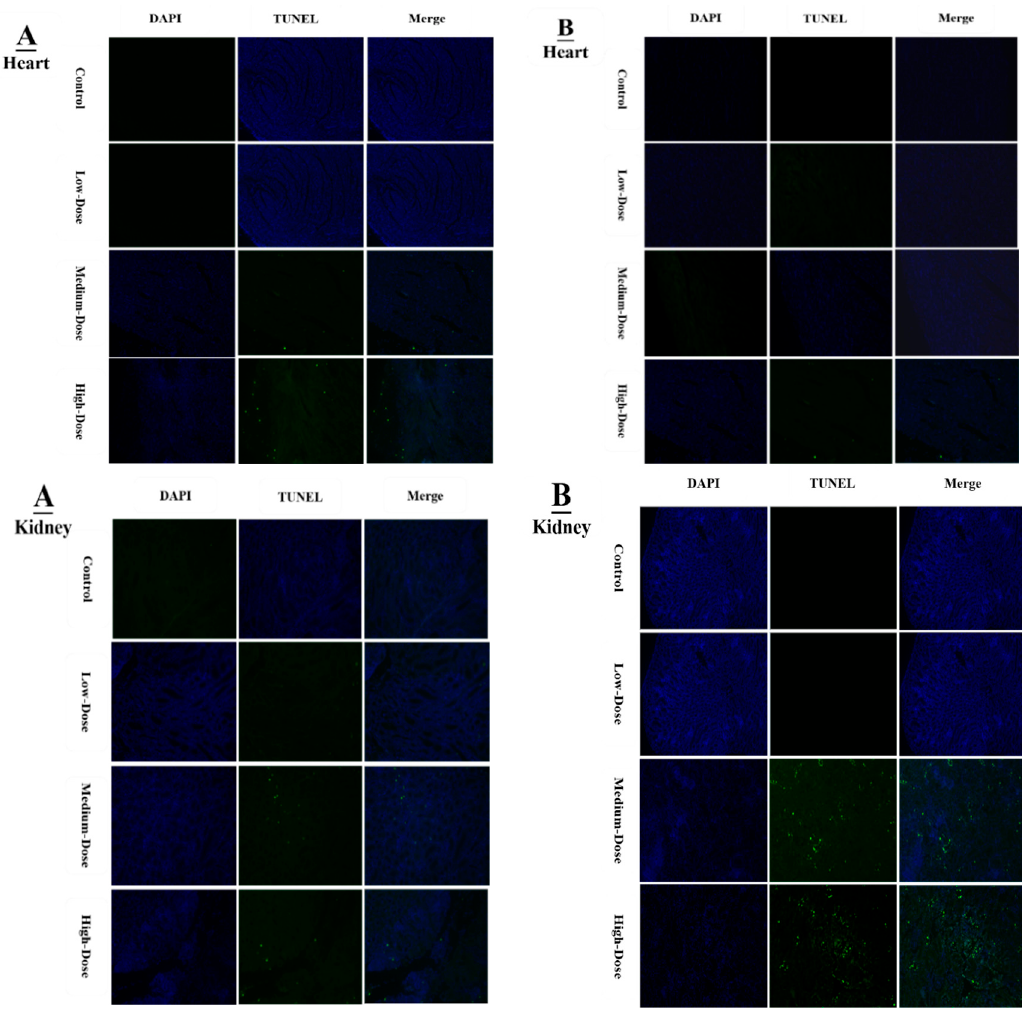
Figure 4. Tunnel assay of heart and kidneys at 07 days ( A ) and at 28 days ( B ) of age by immunofluorescence. The blue color represents the total cells in the heart and kidneys, and the green color represents the apoptosis cells in the heart and kidneys with three different doses of DB (low-dose, medium-dose and high-dose).